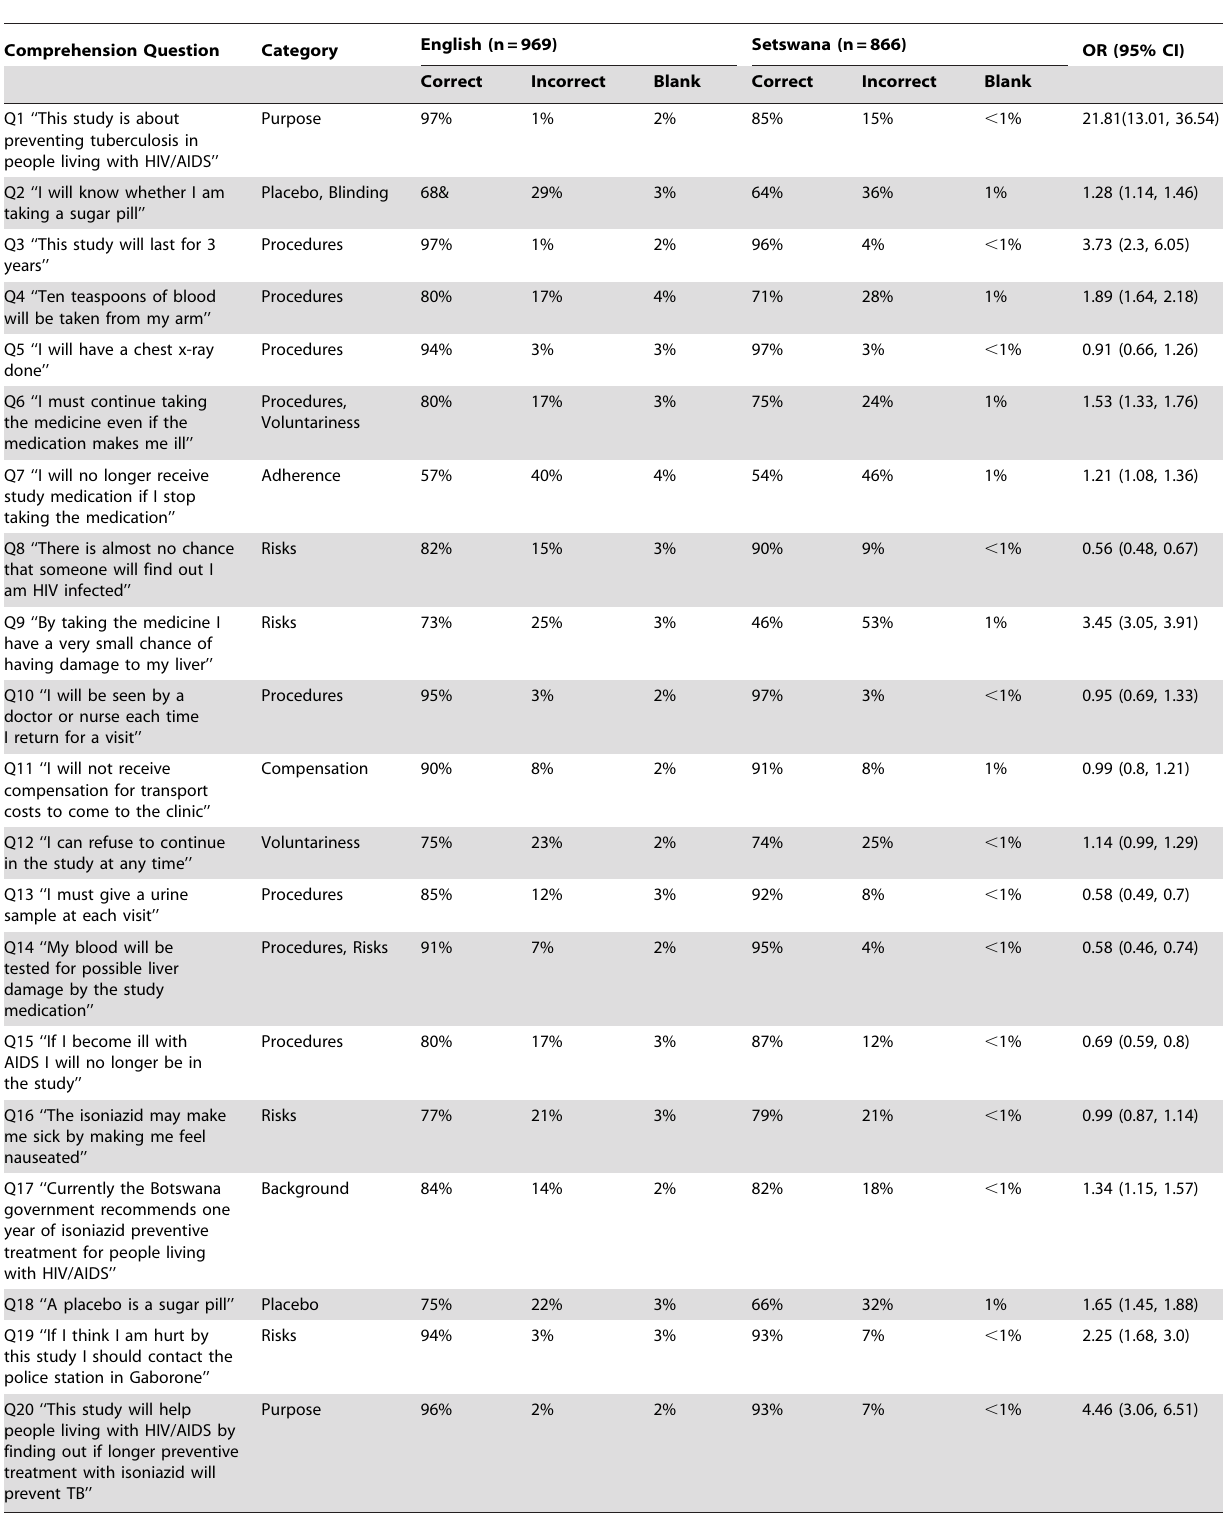
Table 7. Proportion of participants answering comprehension quiz questions 1–20 correctly (English & Setswana); Odds of answering correctly if quiz taken in